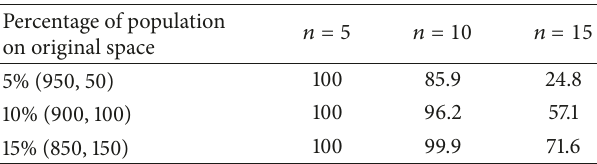
Table 6: Percentage of PDS in the final population for the con- current search approach changing the population ratio between extended and original space. 𝑀 = 4 , overall population size |𝑃| =